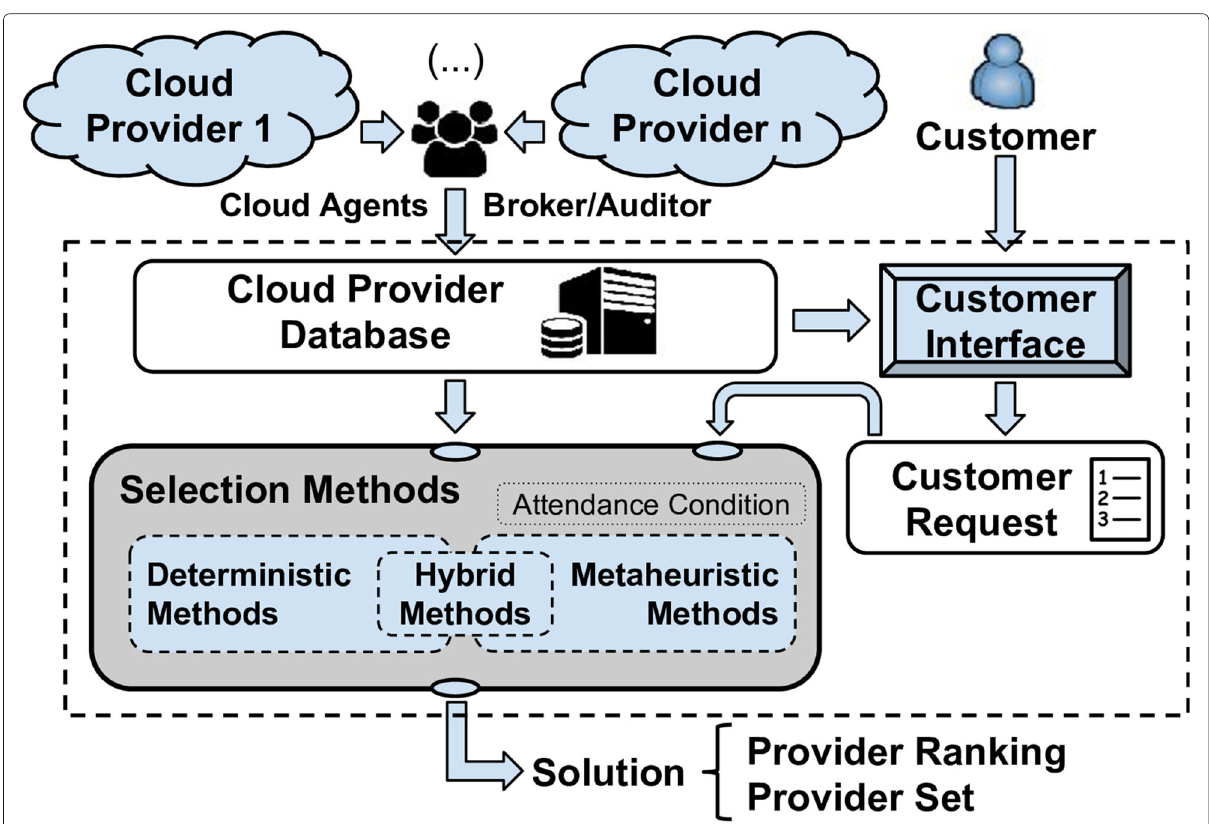
Fig. 1 Pictorial view of the components to approach the CPS problem using